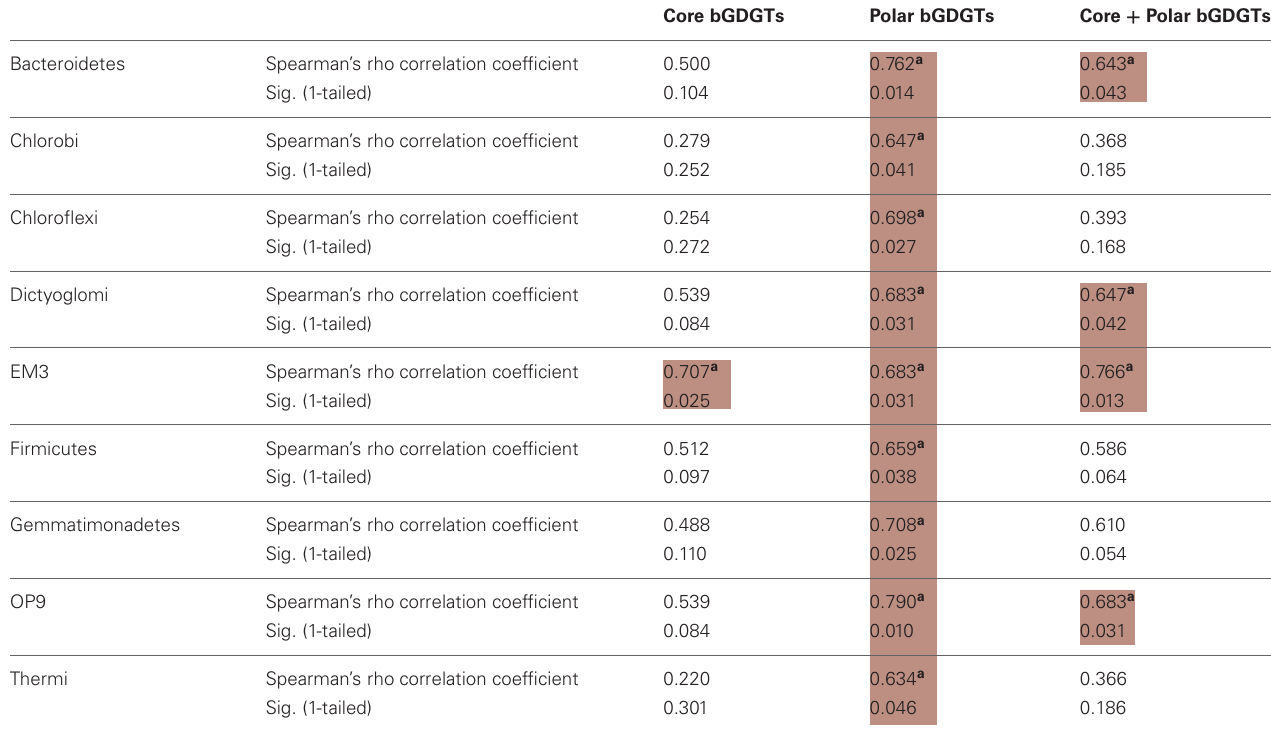
Table A2 | Correlations between normalized bGDGT concentrations (pg lipids/ng DNA) and relative abundance of bacterial phyla b .